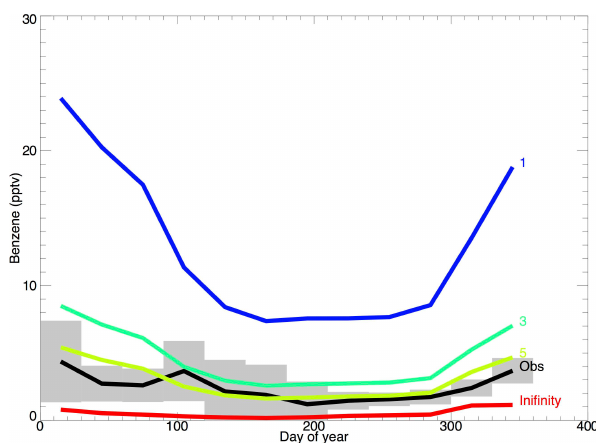
Fig. 3. Comparison of GEOS-Chem model estimate for benzene and observations made at the Cape Verde GAW observatory. Bars indicate ranges of monthly data and the black line the observed aver- age. The blue line indicates the model estimate using biomass burn- ing and RETRO emissions inputs. The two green lines (3) and (5) show the estimated benzene reducing benzene in RETRO by · 0.2 and · 0.33 respectively. The red line shows the model when no an- thropogenic emissions are